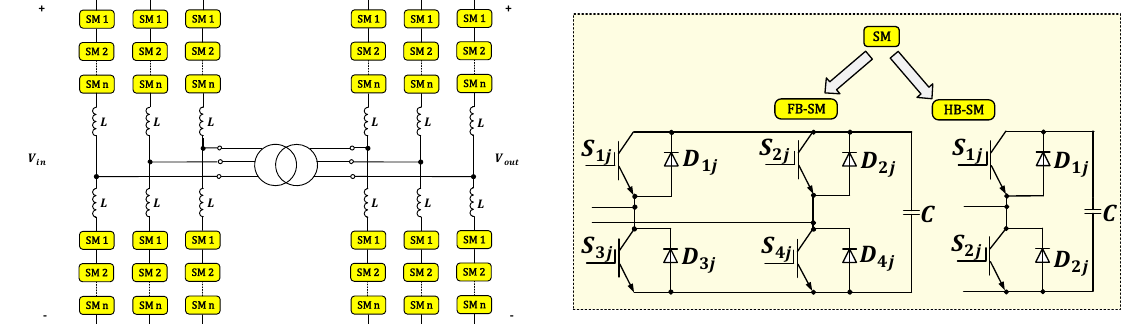
Figure 14. MMC-based Front-to-Front (F2F) topology circuit diagram.